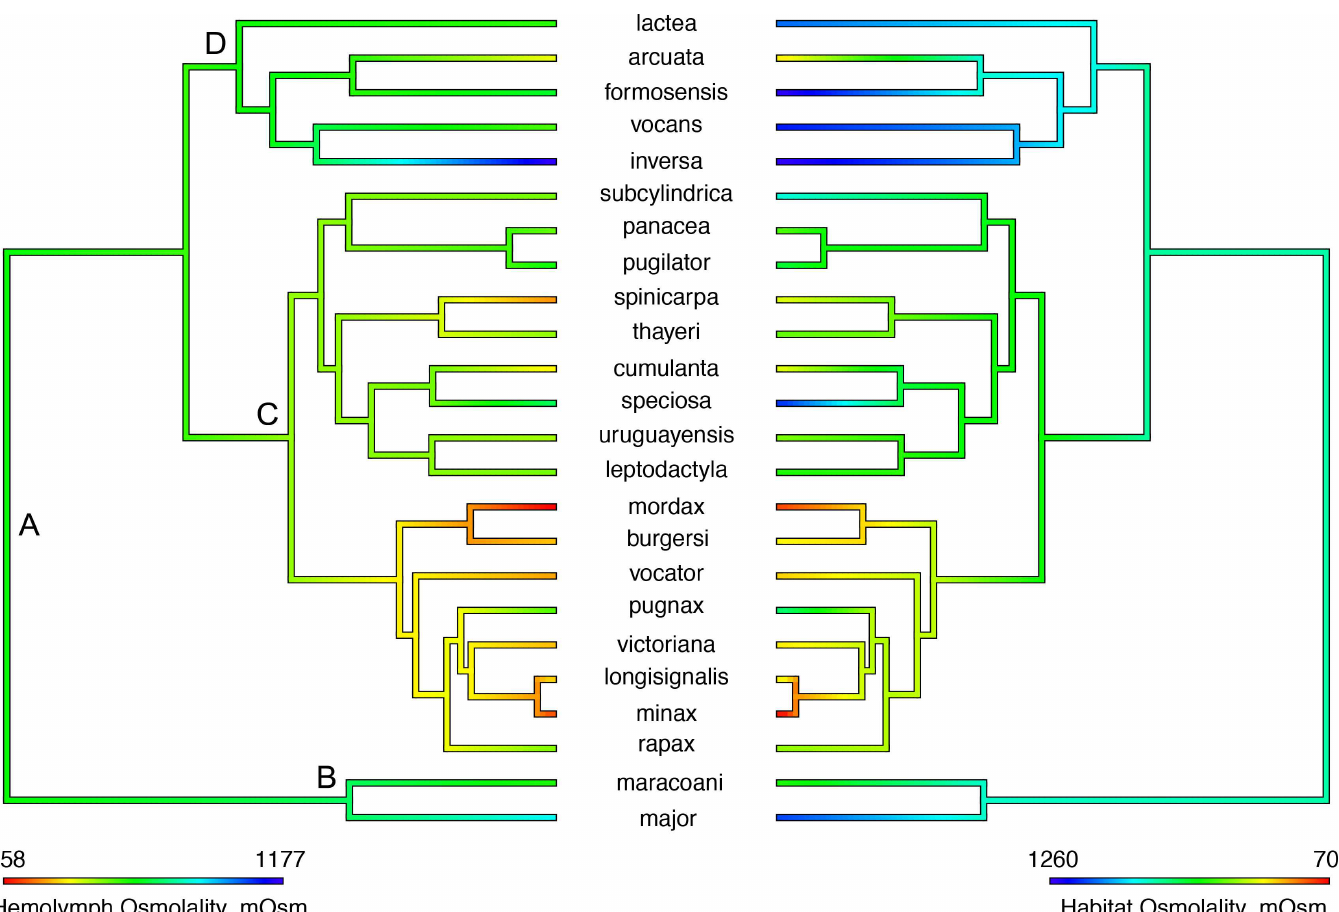
Fig 4. Estimation of ancestral states by maximum likelihood analysis for habitat osmolality (mOsm/kg H 2 O, left panel, 1 ‰ salinity = 30 mOsm/kg H 2 O) and hemolymph osmolality (mOsm/kg H 2 O, right panel) in the fiddler crab topology modified from Shih et al. (2015). Both traits are positively associated(PGLS slope = 0.30, F = 43.8, P < 0.001, α = 2.1) suggestingcorrelatedevolution. A, B, C and D are natural groupingsparticularlyrelevantto the interpretation of osmoregulatory evolution[A, genus Uca ; B and C, American clades; D, Indo-west Pacific